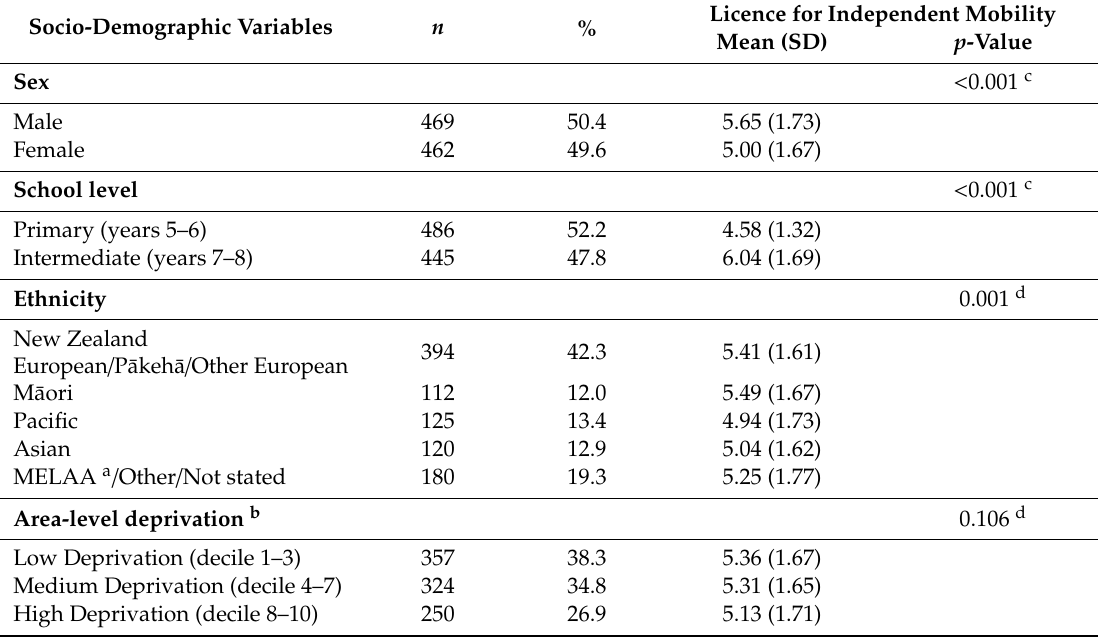
Table 3. Socio-demographic characteristics of children and their licence for independent mobility ( n =